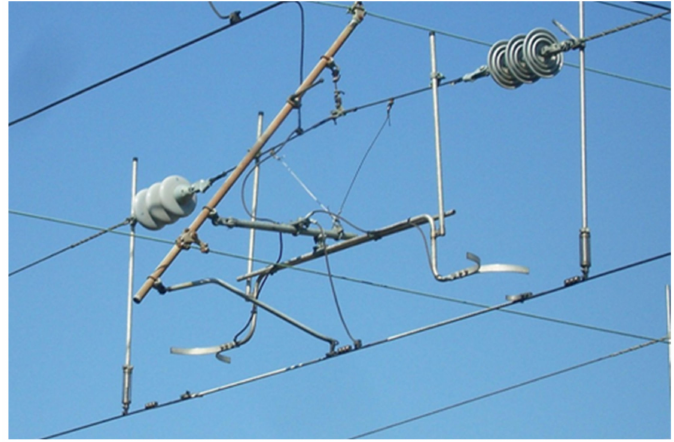
Figure 4. BR type ‘skidless’ ceramic bead neutral section installed in the line (photo Daniel Beardsmore). The design was a conventional AF 25 kV type, NS25-UK-10 [13] in use elsewhere in Europe and around the world. It consisted of two parallel PTFE covered rods, terminated in non-ferrous end fittings, skids and integrated arcing horns. Two sets of these were mounted symmetrically around the support point, supported at the contact wire/rod end fittings by adjustable droppers. This arrangement is shown in the photograph in Figure 5a.